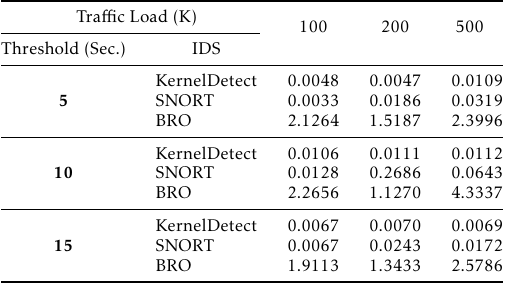
Figure 11. ROC Curve for threat detection for each IDS under 100K Packets SYN flood attack using various thresholds of 5, 10 and 15 seconds for threat signatures of a DoS attack. Table 1. A comparison of the average inspection time in seconds among KernelDetect, SNORT and BRO under various traffic loads of 100K, 200K, and 500K SYN flagged packets using detection thresholds of 5, 10, and 15